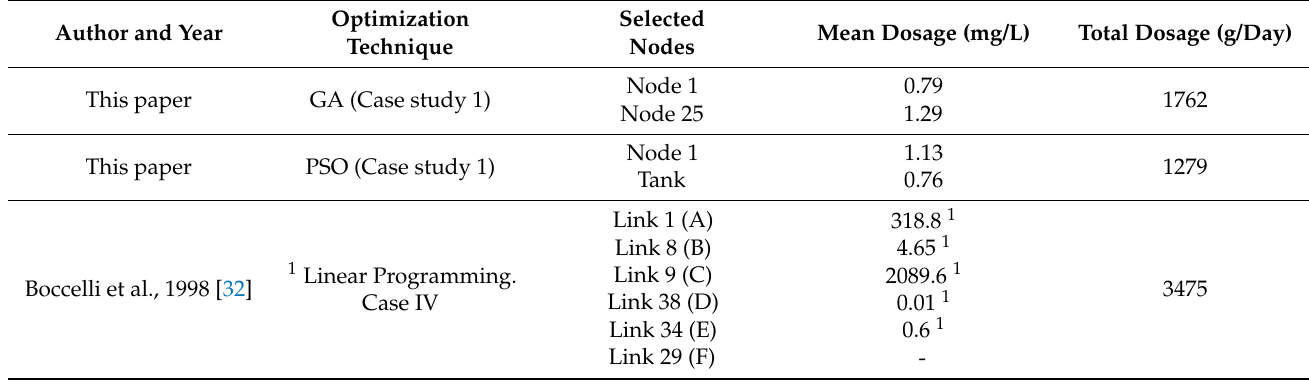
Table 4. Comparison of the total mass injected by the CBS obtained with GA and PSO with those described in the literature review for Case 1.